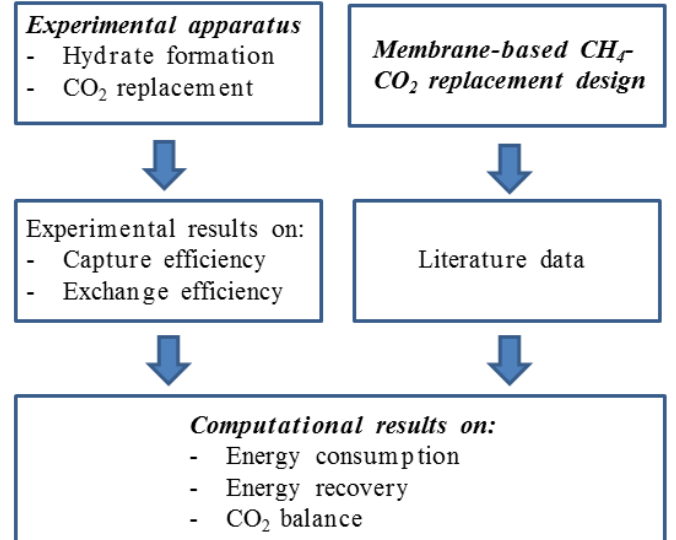
Figure 1. Flowchart of the methodology used.